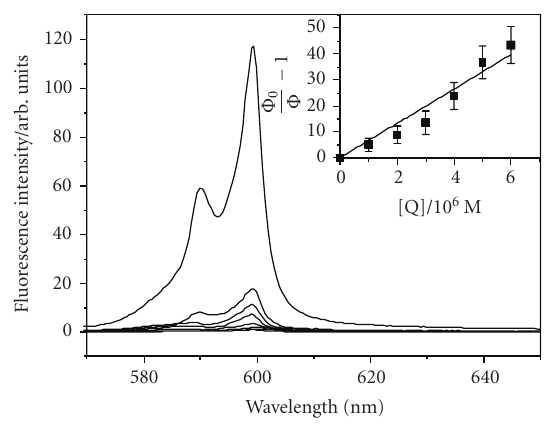
Figure 4: Fluorescence emission spectra of C8S3 aggregates for in- creasing concentrations of Na 2 PdCl 4 ; corresponding to the absorp- tion spectra of Figure 2. Excitation wavelength was 550 nm. Insert: Stern-Vollmer plot of relative fluorescence intensity Φ / Φ 0 versus quencher concentration [Q], which is assumed to be the concen- tration of Na 2 PdCl 4 .